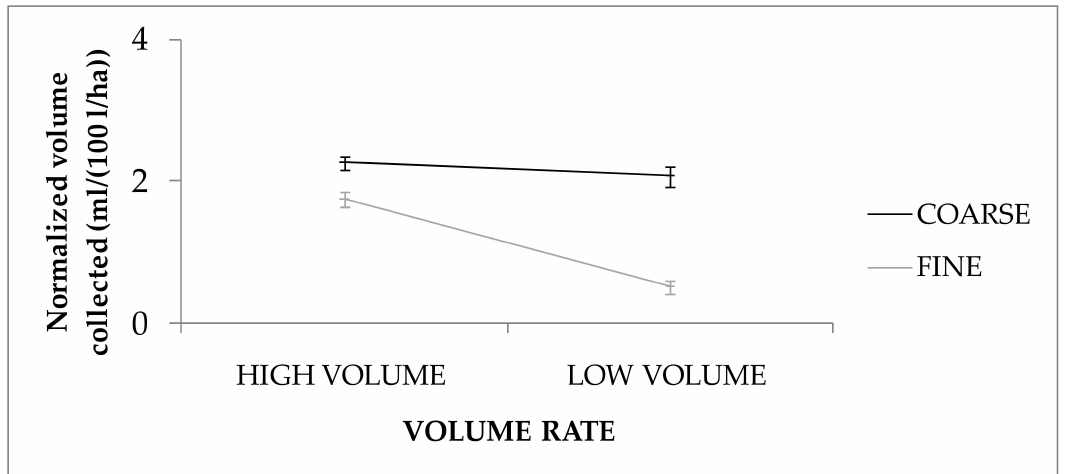
Figure 20. Volume rate × Nozzle type interaction effect on the normalized volume collected above the Canopy height (mean ± SE) with the C1